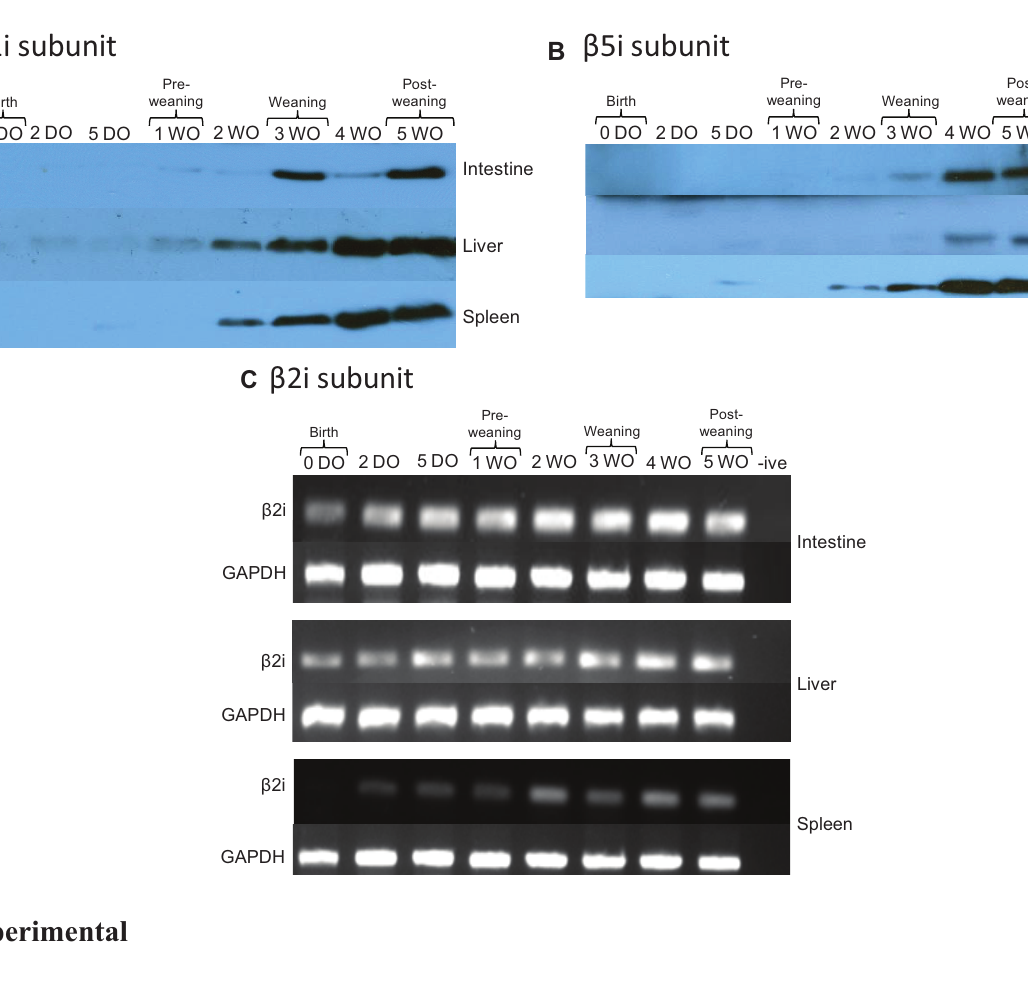
Figure 4. Expression of immunoproteasome subunits during development. Expression of (cid:2)1i ( A ) and (cid:2)5i ( B ) were measured by Western blot analysis. Proteasomes were affinity-purified and the concentrations of purified protein isolated from intestine, liver, and spleen tissue were measured using the BCA protein quantification method. The presence of the (cid:2)2i subunit (and housekeeping gene GAPDH) was assessed by RT-PCR using tissues homogenized with TRIzol reagent ( C ). The data shown are representative of three independent